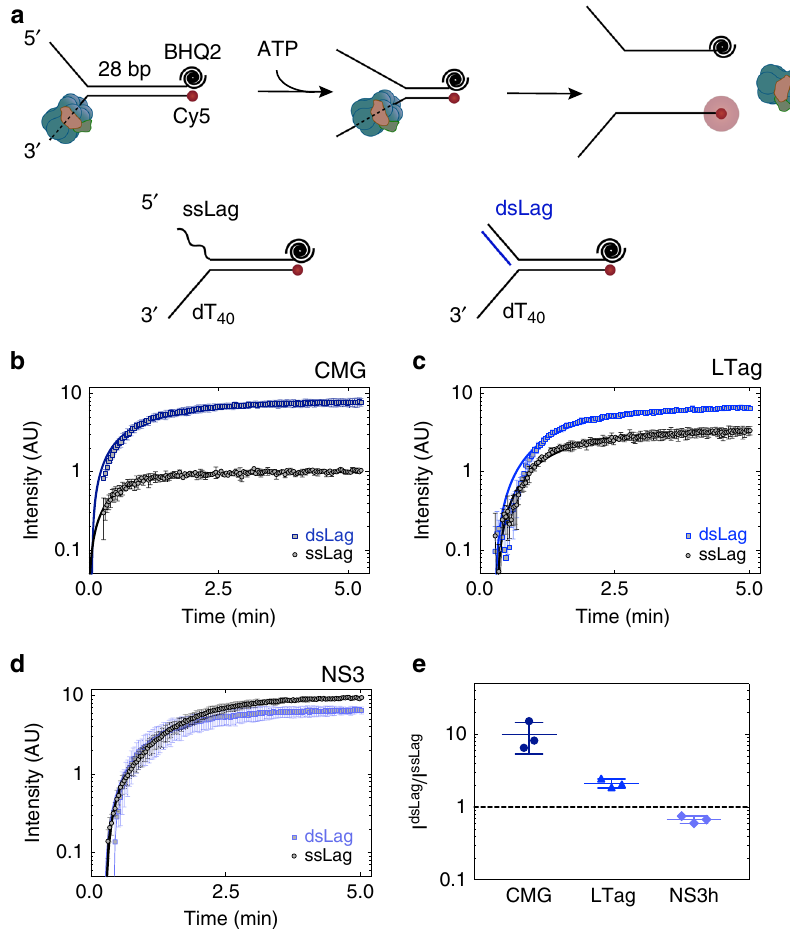
Fig. 3 Duplex DNA engagement by CMG at the fork impedes its helicase activity. a – d Single-turnover unwinding of fork DNA substrates containing ss (black) or ds (blue) lagging-strand arm by CMG b , large T antigen c , and NS3 d . DNA substrates contained 28-bp duplex region and were modi fi ed with Black Hole Quencher 2 (BHQ2) at the 3 ′ -end of the lagging-strand template and Cy5 at the 5 ′ -end of the leading-strand template. Solid lines represent fi ts to Eq. (2) in b and Eq. (3) in c and d (see Methods). e The ratio of fl uorescence plateau intensity on Fork dsLag to Fork ssLag indicates that DNA stimulation of fork DNA unwinding by duplexing the lagging-strand arm is helicase dependent. All data represent mean ± SD ( n = 3 independent experiments). Source data are provided as a Source Data fi